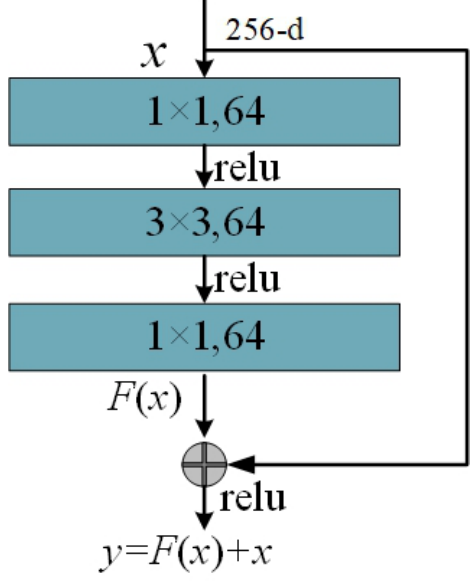
Figure 2. Structural diagram of residual module.